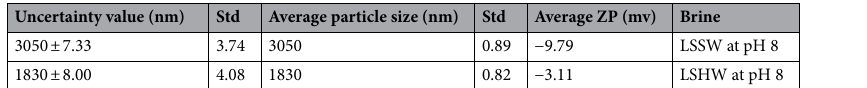
Table 12. Effect of types of ionic compositions on surface